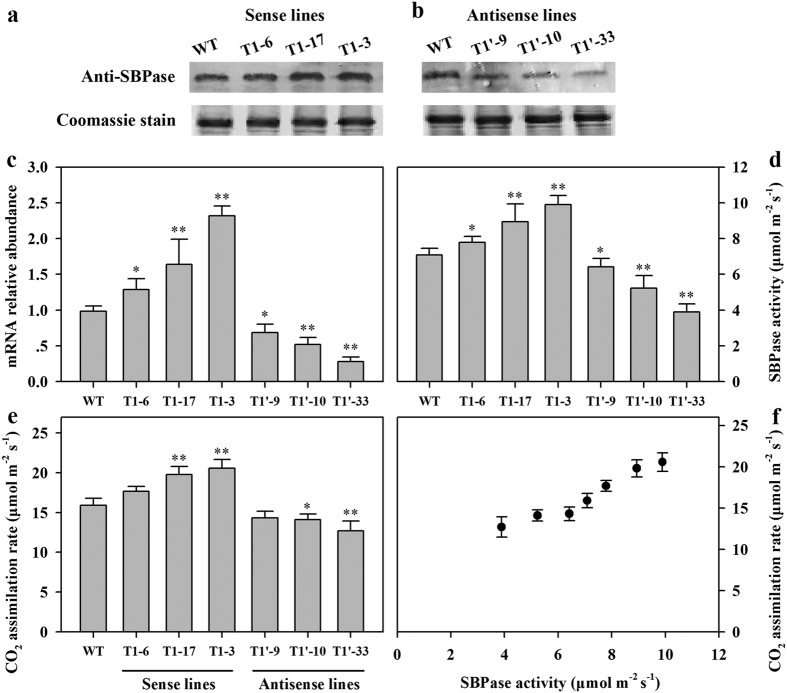
SlSBPase mRNA abundance, SBPae protein level, SBPase activity and CO2 assimilation rate in different transgenic lines.All measurements were done on 12-leaf wild-type and T1 progeny of transgenic tomato plants. (a,b) Protein levels. 25 μg protein samples from the fully expanded leaves (leaf no. 8, 9 from base) in wild-type and transgenic tomato plants were separated by SDS-PAGE. SBPase protein was stained by coomassie blue and was subjected to western blot analysis with an anti-SBPase polyclonal antibody. (c) SlSBPase mRNA abundance was analyzed by quantitative real-time PCR using total RNA isolated from the fully expanded leaves (leaf no. 8, 9). (d) SBPase activity was assayed using the same tissues for SlSBPase mRNA analysis. (e) CO2 assimilation rate measurements were made on the fully expanded leaves (leaf no. 8, 9) in greenhouse conditions. (f) Effect of changes in SBPase activity on CO2 assimilation rate under greenhouse conditions. The results are the means ± SDs (n = 5). Asterisks indicate significant differences between WT and transgenic plants (* for P < 0.05; ** for P < 0.01).